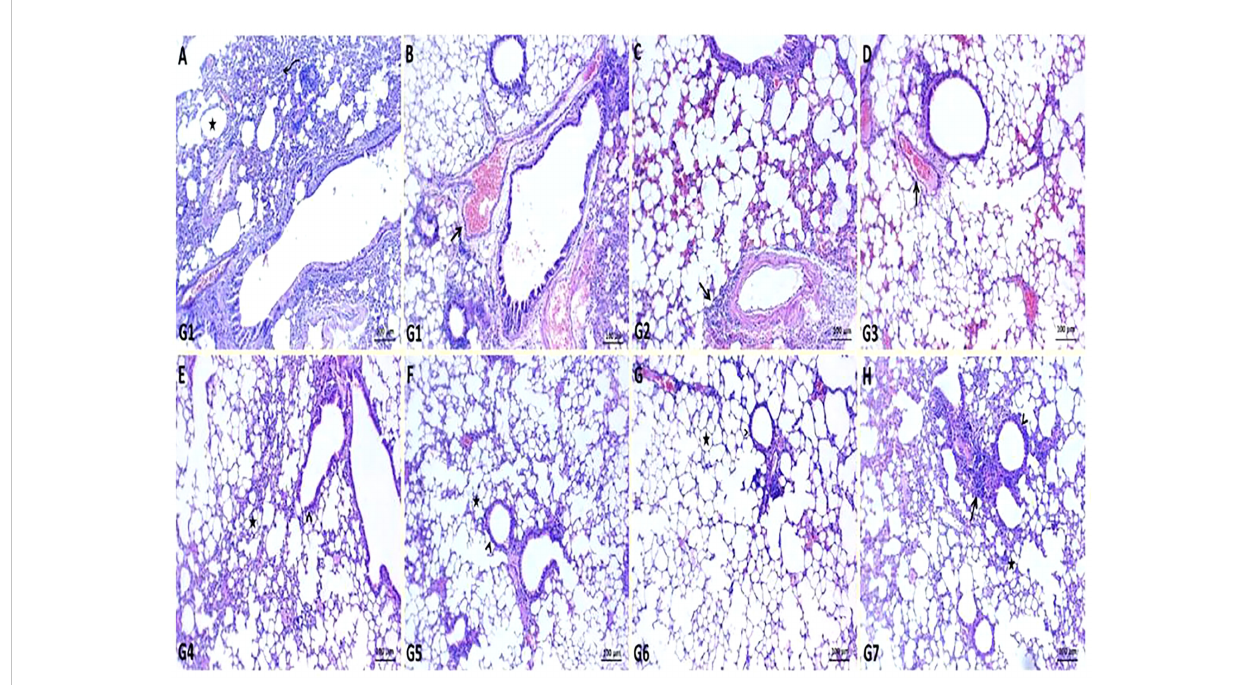
FIGURE 4 Representative photomicrographs of lung sections of different groups in K . pneumoniae mouse model. (A, B) : pneumonic changes (curved arrow) alternated with emphysematous changes (star) and dilated pulmonary blood vessels (arrow) in control positive group (G1), (C) : normal bronchiole (arrowhead) with prominent lymphoid follicles within their walls (arrow) and normal alveoli (star) in gentamicin treated group (G2), (D) : restoration of normal architectures of pulmonary tissue with perivascular in fl ammatory cell in fi ltrates (arrow) in ursolic acid methyl ester-treated group (G3), (E) : apparent normal bronchi and alveolar epithelium with presence some dilated vasculatures (arrowhead) in saline control negative group (G4), (F) : normal pulmonary tissue, bronchiole (arrowhead), and alveolar structures (star) in tween-20 control negative group (G5), (G) : normal bronchi, bronchioles (arrowhead), alveolar ducts, and alveoli (star) in ursolic acid methyl ester control negative group (G6), (H) : normal histomorphological structures of epithelial lining bronchi, bronchiole (arrowhead), and alveoli (star) in gentamicin control negative group (G7). H&E, scale bar 100 m